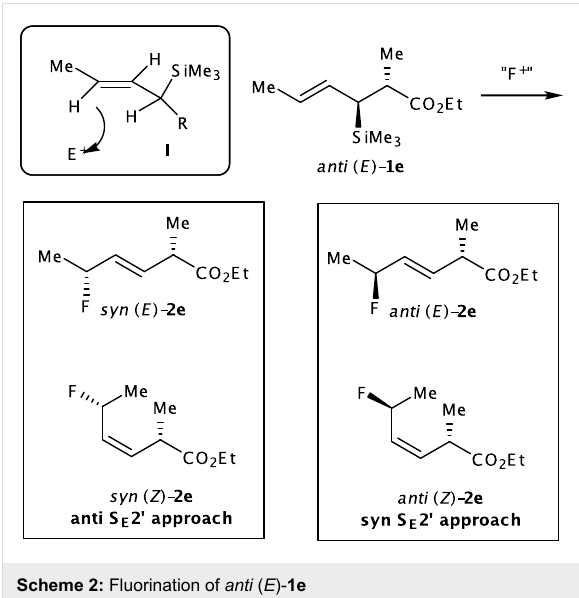
was very efficient. A third allylic fluoride was detected in the crude mixture and its structure was tentatively assigned as